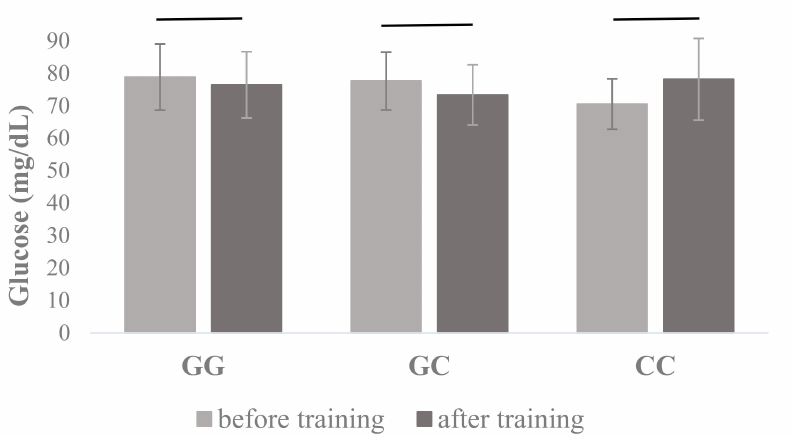
Figure 2. Changes in plasma glucose concentrations measured before and after the completion of the 12-week training program in carriers of di ff erent PPARA I7 rs4253778 genotypes. The values are mean ± SD.